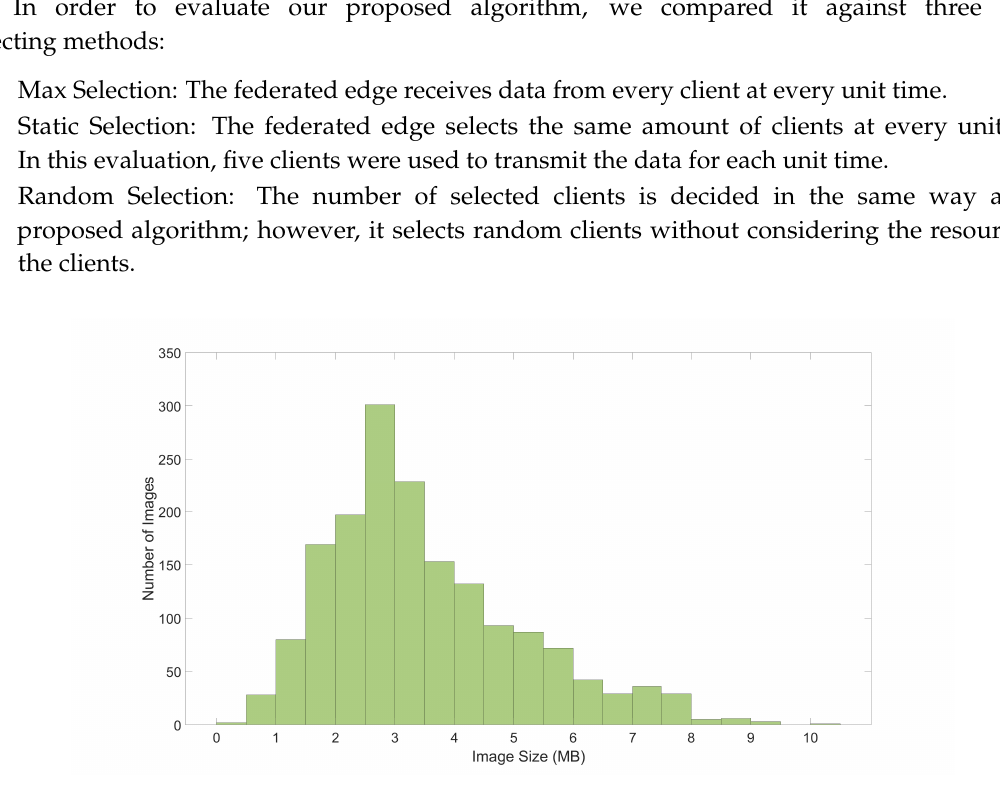
Figure 7. Data size distribution of author’s mobile device.